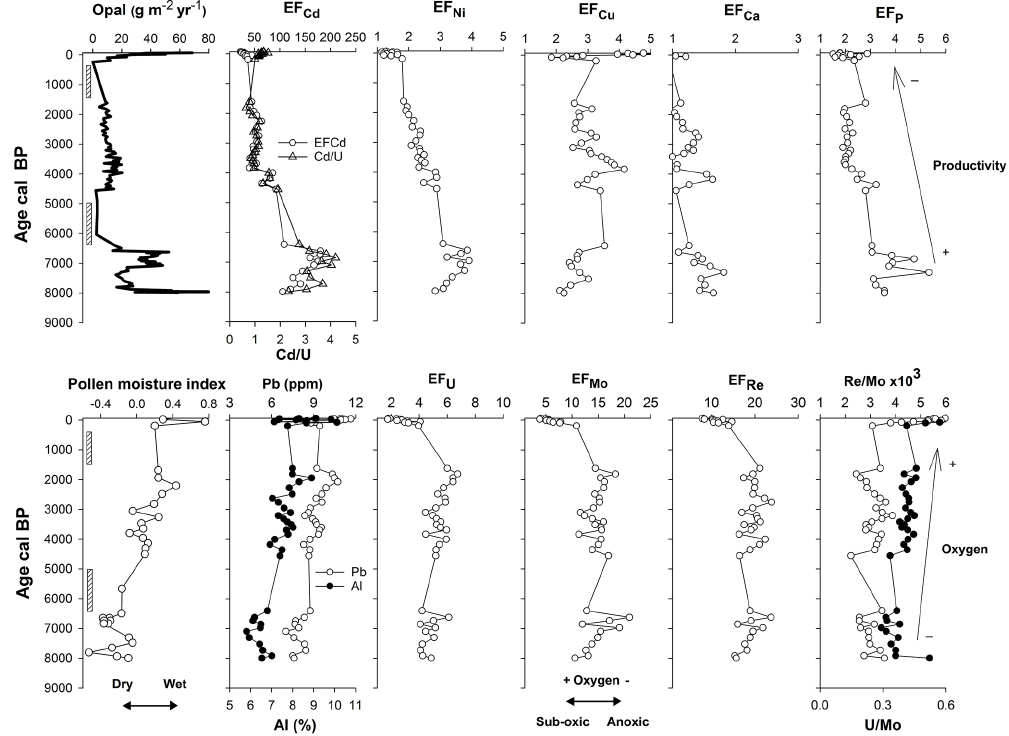
Figure 9. Opal accumulation and authigenic enrichment factor (EF) of trace elements calculated for Guanaqueros Bay (core BGGC5). Lithogenic background was estimated from the surface sediments of Pachingo wetland cores (see text). Pollen moisture index defined as the normalized ratio between Euphorbiaceae (wet coastal shrubland) and Chenopodiaceae (arid scrubland). Positive (negative) values for this index indicate the relative expansion (reduction) of coastal vegetation under wetter (drier) conditions. Pb and Al distribution for core BGGC5, representative of terrigenous input to the